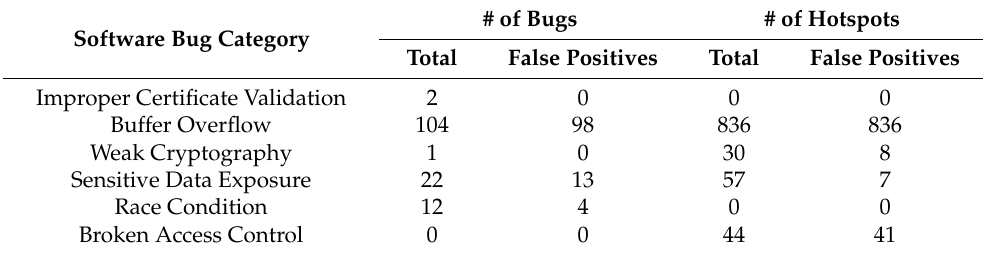
Table 19. Overall statistics of the analysis performed on all examined software. # of Bugs # of Hotspots Software Bug Category Total False Positives Total False Positives Improper Certificate Validation 2 0 0 0 Buffer Overflow 104 98 836 836 Weak Cryptography 1 0 30 8 Sensitive Data Exposure 22 13 57 7 Race Condition 12 4 0 0 Broken Access Control 0 0 44